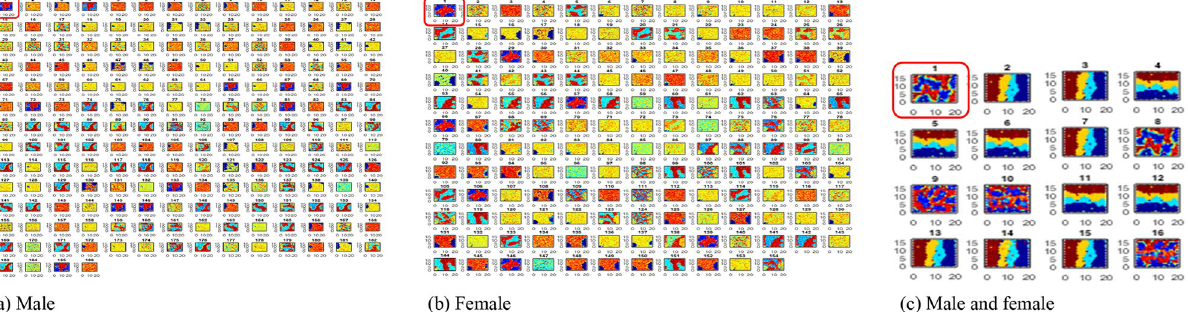
Figure 8. SOM component planes visualization for South American and Oceanian isolates. Component planes 1 (encircled) represent the SARS-CoV-2 reference genome. For South American isolates, the male isolates ( a ) and female isolates ( b ) have 1 SOM map each. For Oceanian isolates, the male and female isolates ( c ) are condensed into 1 map, each with country and (component plane map position(s)) distributed as follows: Male—